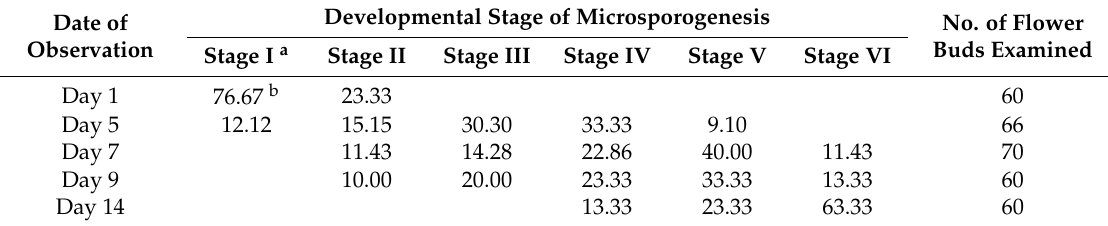
Table 1. Microsporogenesis stages of flower buds in selected floral branches on different days in Eucalyptus urophylla